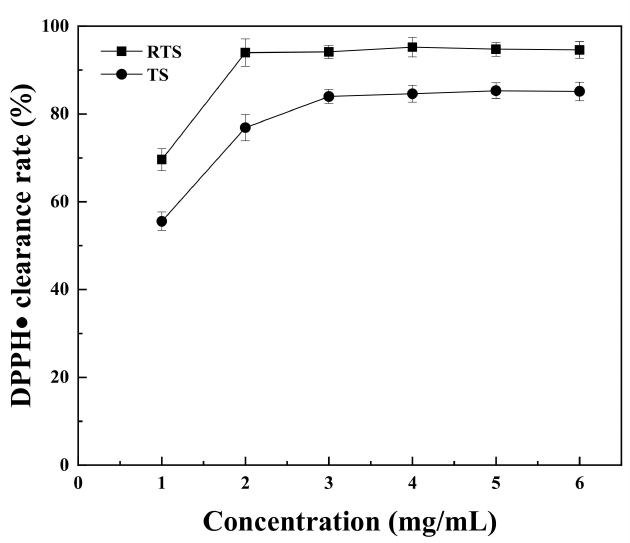
Figure 7. The DPPH scavenging activity levels of RTS and TS.